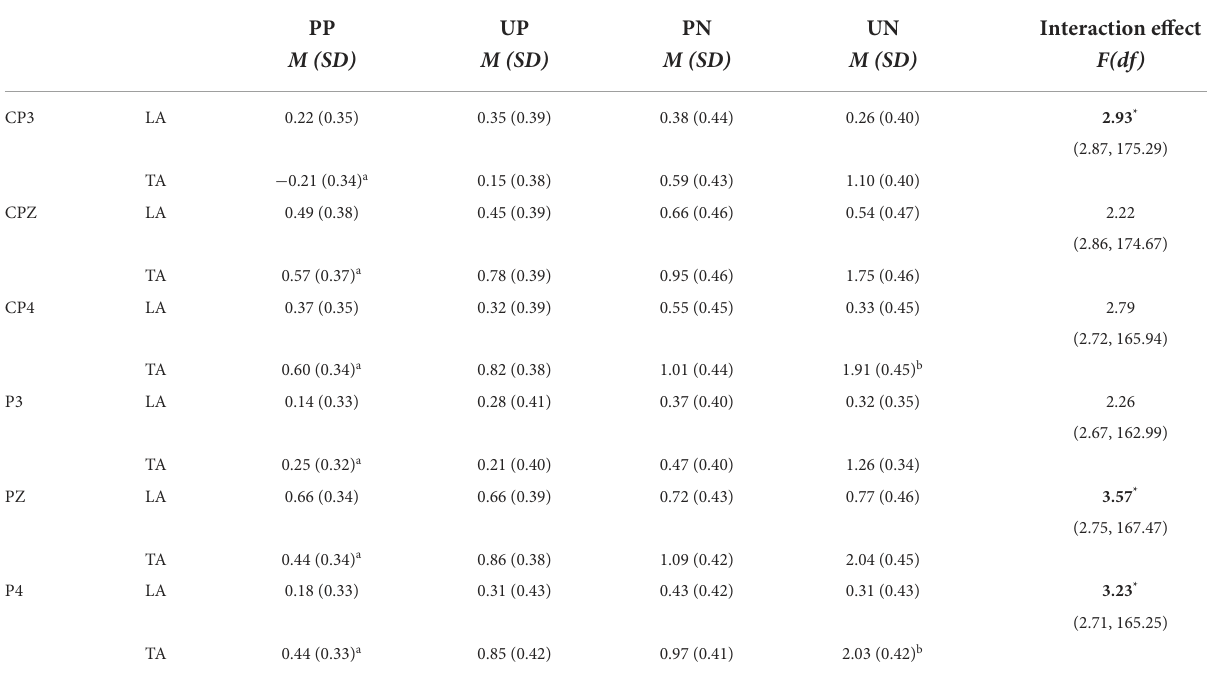
TABLE 4 Results of the rmANOVA on two groups and four conditions for LPP. PP